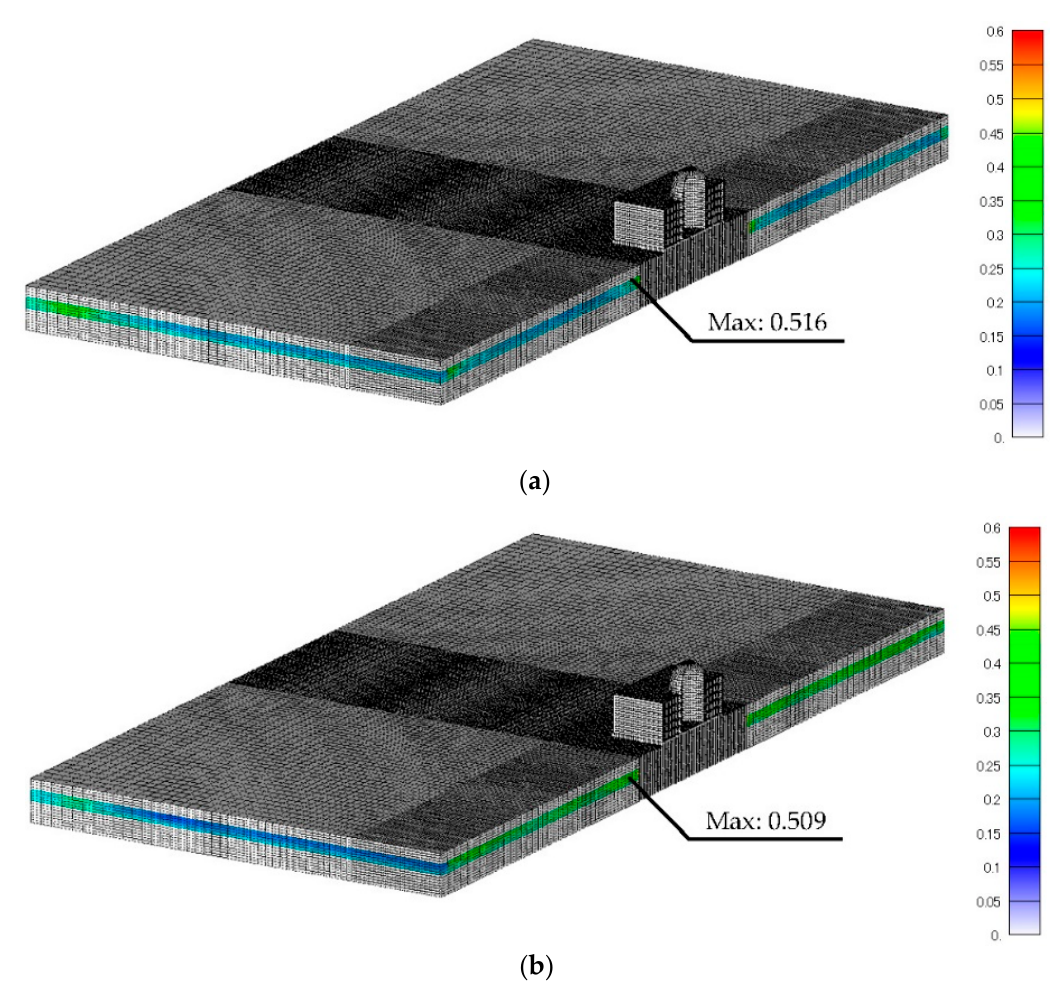
Figure 14. The excess pore water pressure ratio distribution at 15.36 s in ( a ) the original model and ( b ) the proposed model.